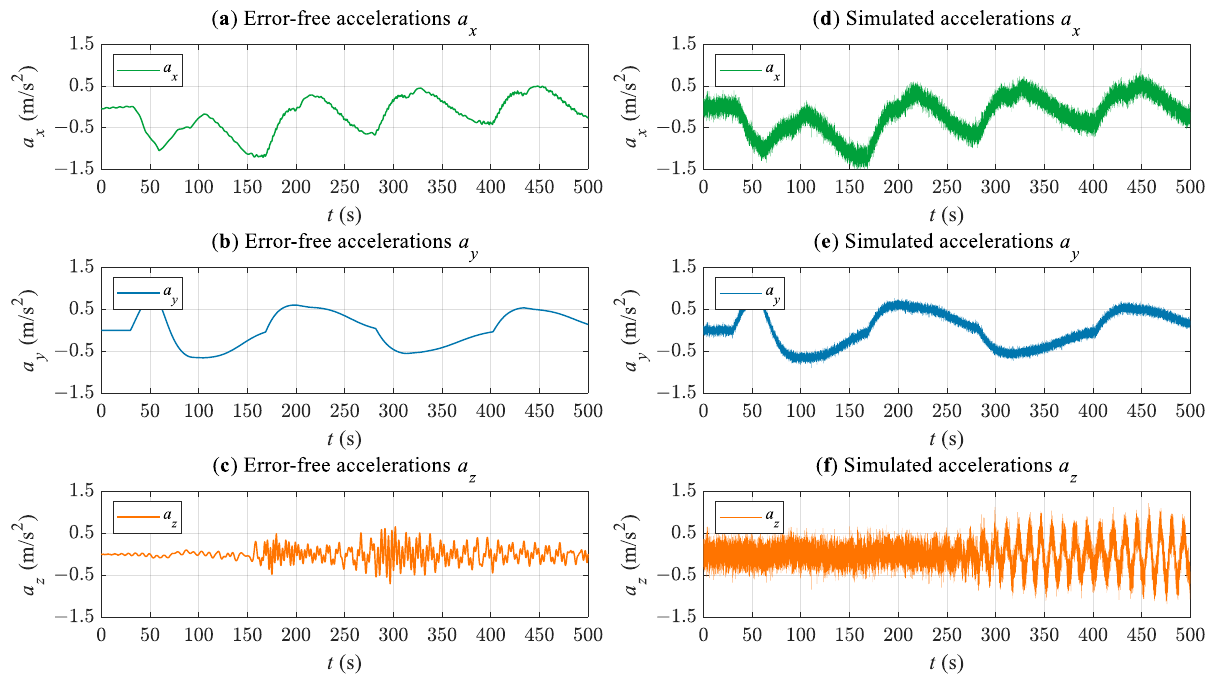
Figure 8. Error-free and simulated accelerations. ( a ) error-free accelerations of x direction; ( b ) error-free accelerations of y direction; ( c ) error-free accelerations of z direction; ( d ) simulated accelerations of x direction; ( e ) simulated accelerations of y direction; ( f ) simulated accelerations of z